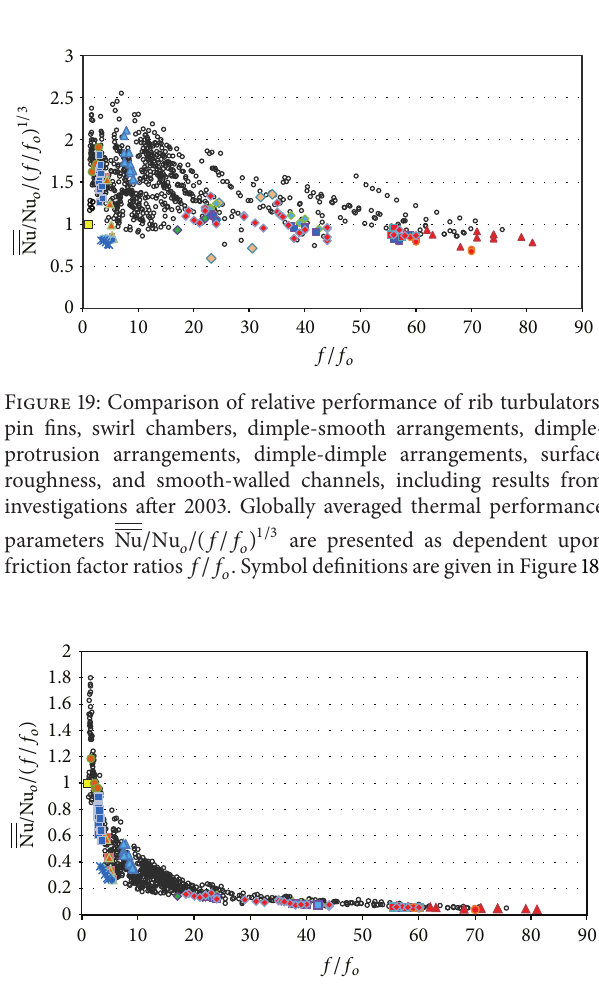
Figure 20: Comparison of relative performance of rib turbulators, pin fins, swirl chambers, dimple-smooth arrangements, dimple- protrusion arrangements, dimple-dimple arrangements, surface roughness, and smooth-walled channels, including results from investigations after 2003. Globally averaged thermal performance parameters Nu / Nu 𝑜 /(𝑓/𝑓 𝑜 ) are presented as dependent upon fric- tion factor ratios 𝑓/𝑓 𝑜 . Symbol definitions are given in Figure 18.